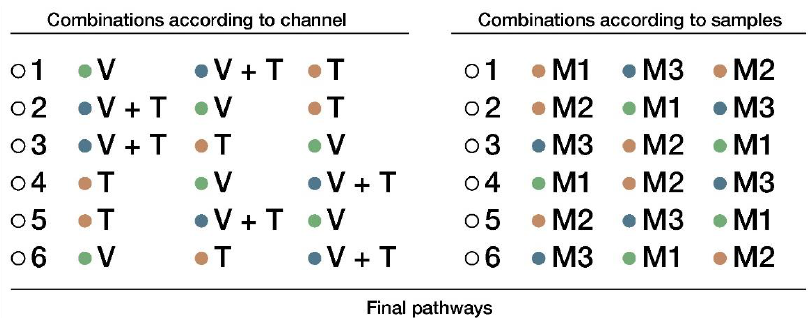
Figure 4. Combinations for material inspection through different final